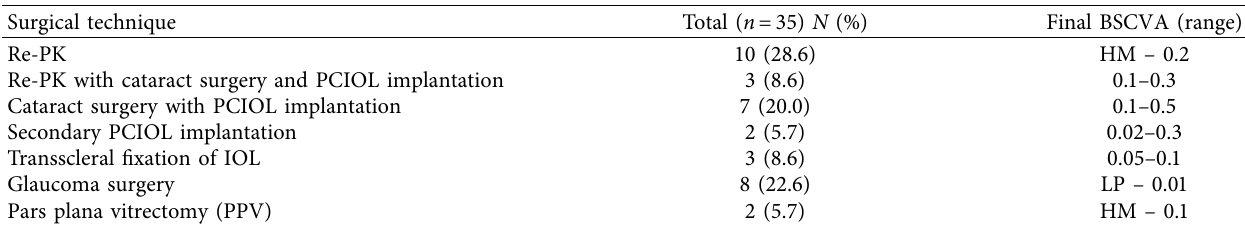
Surgical technique